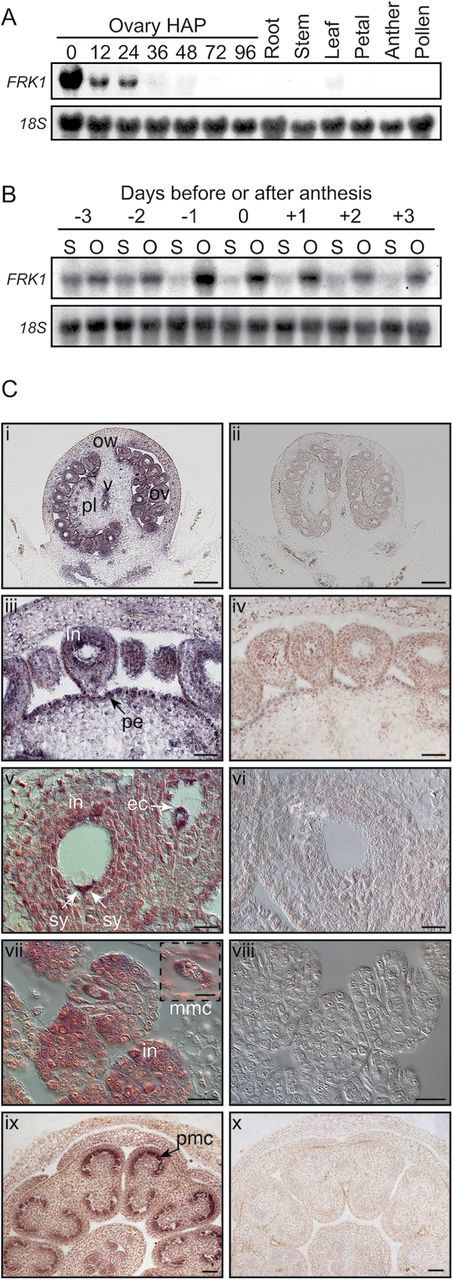

ScFRK1 expression analysis. (A) RNA gel blot analysis of the ScFRK1 gene. All tissues were collected from greenhouse-grown plants. Fertilized ovaries were dissected from pistils 0–96 hours after pollination (HAP). A 10 μg aliquot of total RNA isolated from S. chacoense tissues was blotted and probed using the full-length ScFRK1 cDNA (upper panel). Membranes were stripped and re-probed using a partial 18S rRNA to ensure equal loading of each RNA sample (lower panel). (B) RNA gel blot analysis of the ScFRK1 gene before and after anthesis in unpollinated pistil tissues. S, style; O, ovary. (C) In situ localization of ScFRK1 transcripts in ovules and anthers. (i and ii) Unfertilized mature ovary sections. (iii and iv) Magnification of unfertilized mature ovary sections. (v and vi) ScFRK1 expression in the ovule integument and embryo sac of mature ovules at anthesis. (vii and viii) ScFRK1 expression in young ovules at the megaspore mother cell stage isolated from ~2mm flower buds. (ix and x) Cross-sections of young anthers isolated from ~2mm flower buds. i, iii, v, vii, and ix, antisense probe. ii, iv, vi, viii and x, control sense probe. Digoxigenin labelling is visible as red to purple staining. All hybridizations used 10 μm thick sections and an equal amount of either ScFRK1 sense or antisense probe. ec, egg cell; in, integument; mmc, megaspore mother cell; ov, ovule; ow, ovary wall (pericarp); pe, placenta epidermis; pl, placenta; sy, synergid, zy, zygote. Images v–viii were taken under DIC optics in order to better show the cellular structures. Scale bars: 200 μm (i, ii); 50 μm (iii, iv, ix, x); and 20 μm (v–viii).